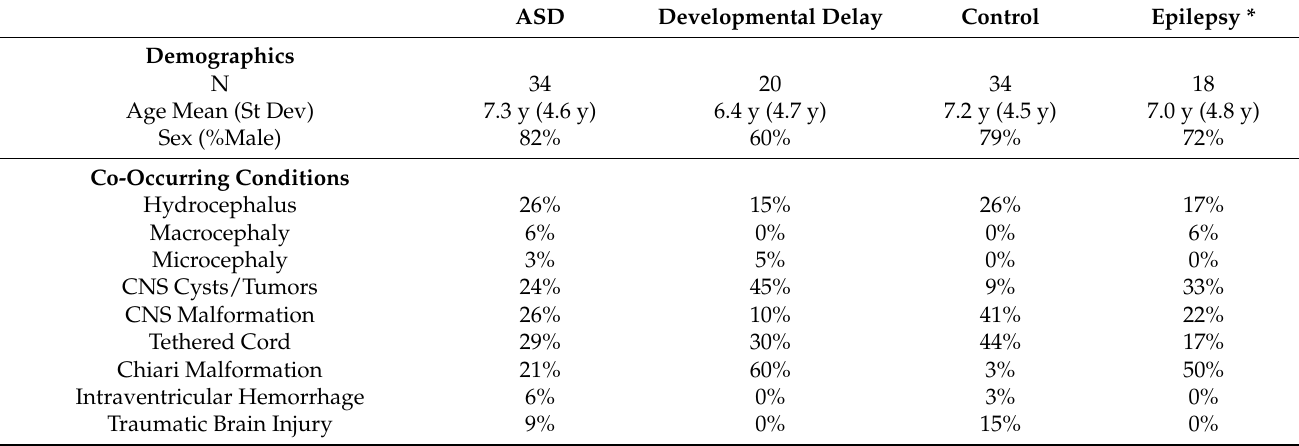
Table 2. Patient demographics and co-occurring